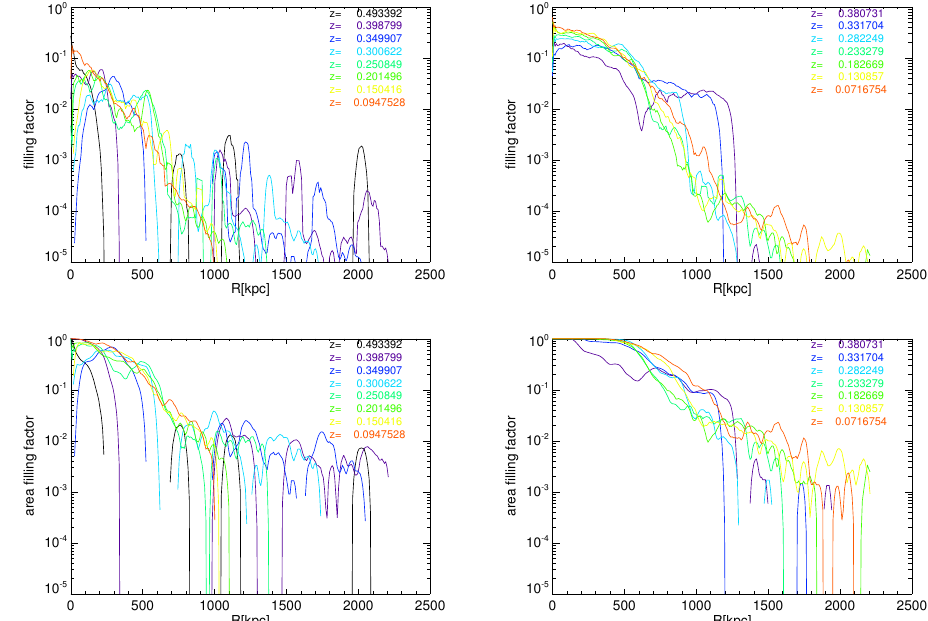
Figure 7. Evolution of the volume filling factor ( top row ) or of the projected area filling factor ( bottom ), for either 3-dimensional or 2-dimensional radial shells centred on the (moving) gas density peak of our simulated cluster of galaxies, for the electrons seeded by radio jets at z = 0.5 ( left panels ) and for the electrons seeded by merger shocks from z = 0.4 ( right panels